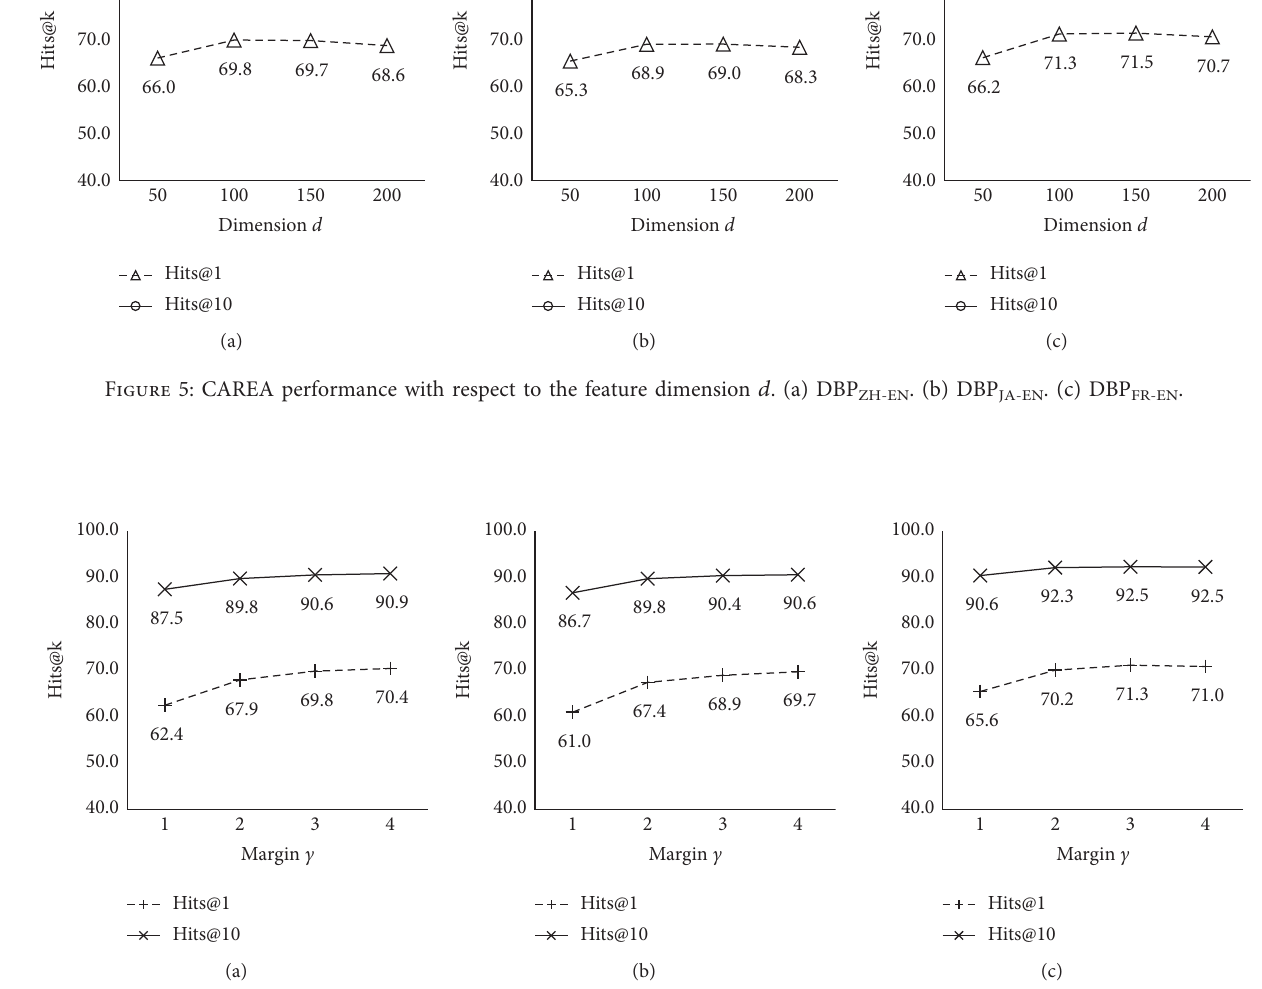
ZH-EN . (b) DBP JA-EN . (c) DBP FR-EN .